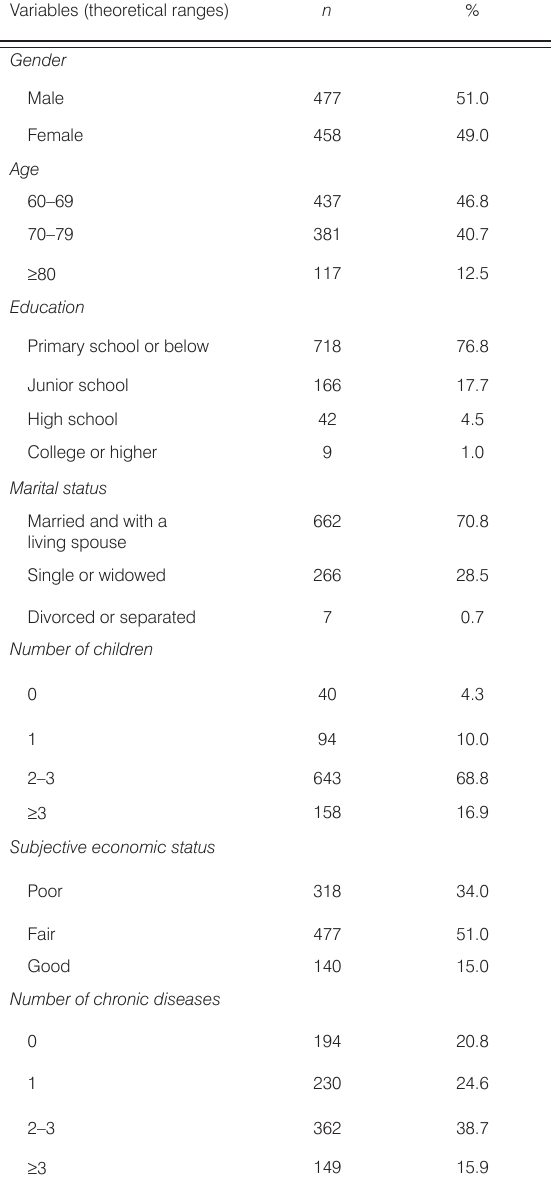
Table 1. Characteristics of participants ( N = 935).